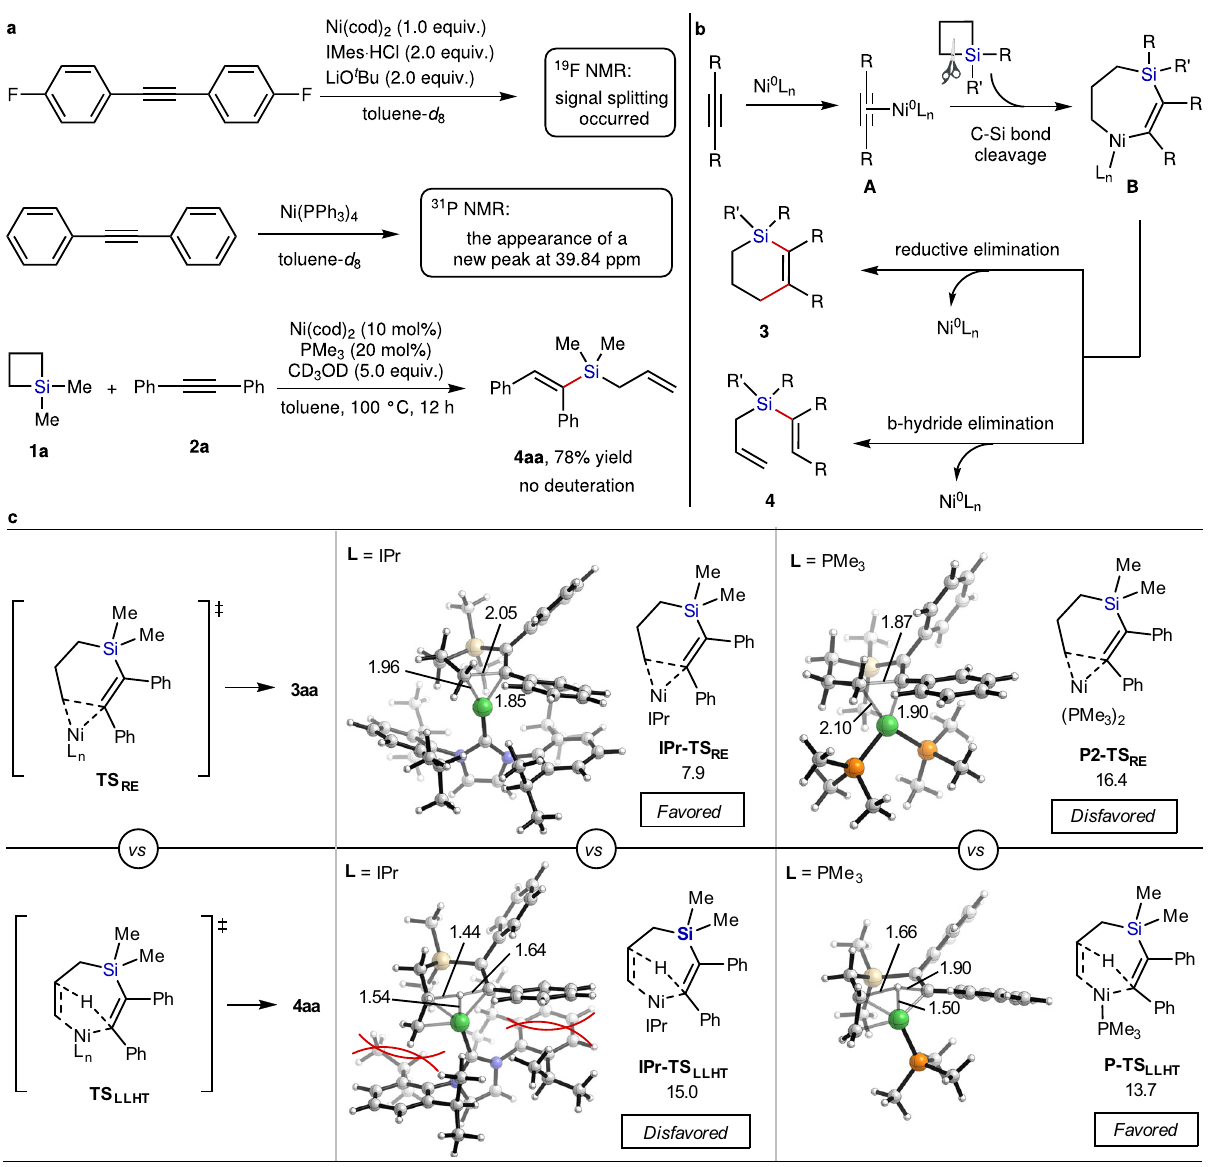
Fig. 4 Mechanistic studies for this Ni-catalyzed divergent reactions of SCBs with alkynes. a Control experiments . b Plausible mechanism. c DFT investigation about mechanistic origin of the ligand-controlled structure divergence in the Ni-catalyzed reaction of SCB 1a with 2a . Free energies are shown in kcal/mol, distances in Å. Ni-silacycloheptene species was used as energy zero.